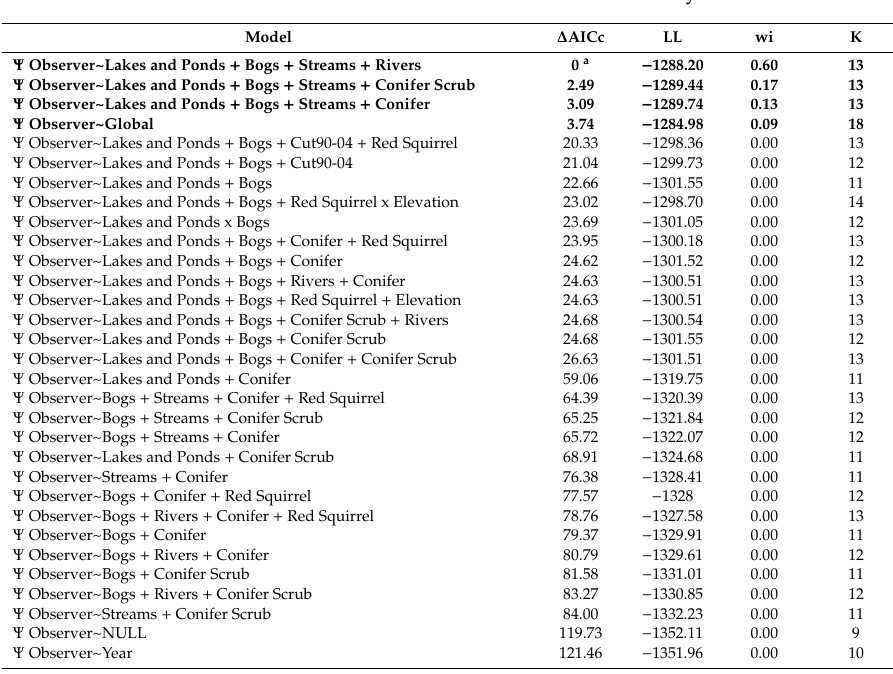
Table 3. Candidate models describing occupancy ( Ψ ) of rusty blackbirds in Newfoundland, Canada, in 2016 and 2017 ( n = 1960 survey points). Models in the 95% confidence set of best models are highlighted in bold. All models include a term for the e ff ect of observer on